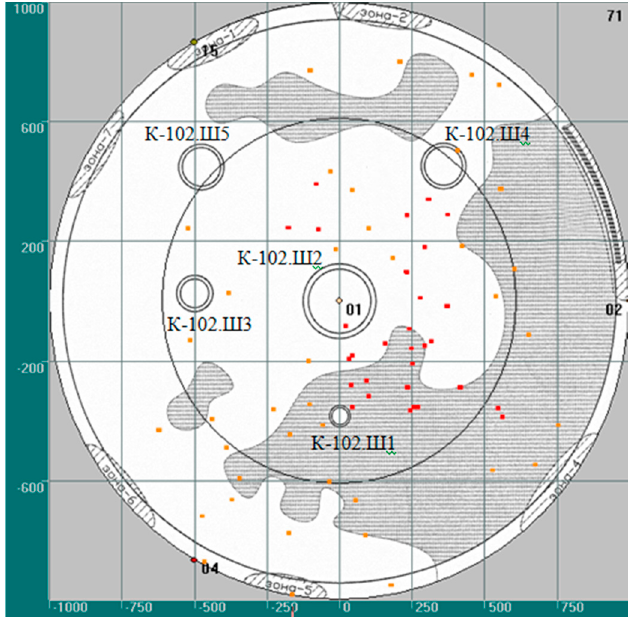
Figure 12. Previously found defects of gas absorber head plate: lamination in the vessel head (gray areas) and locations of the registered AE source (orange). Color of points indicates total number of events in this coordinates. Yellow points: 3–10 events, orange points: 11–25 events, red points: 26–100 events.